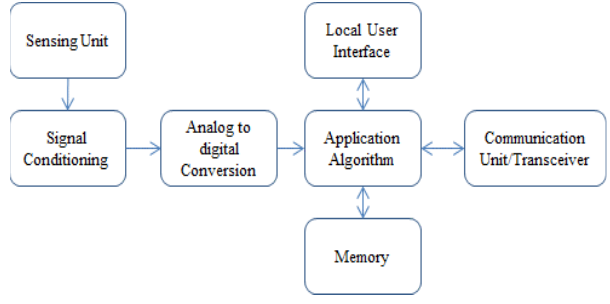
Figure 8. Basic Architectural components of Smart Sensors